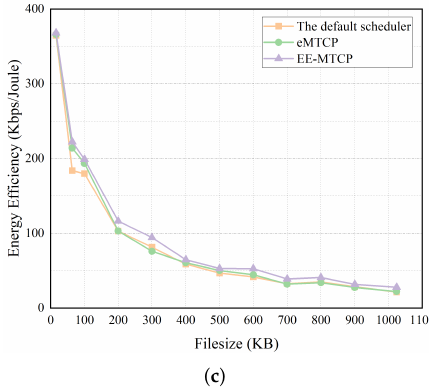
Figure 3. Experimental results conducted with MPTCP Linux kernel reveal that existing algorithms like eMTCP [13] can perform worse than the default MPTCP. The detailed results are shown in Figure 4. ( a ) The energy consumption under different file sizes. ( b ) The throughout under different file sizes. ( c ) Energy efficiency comparison of various algorithms with different file sizes.